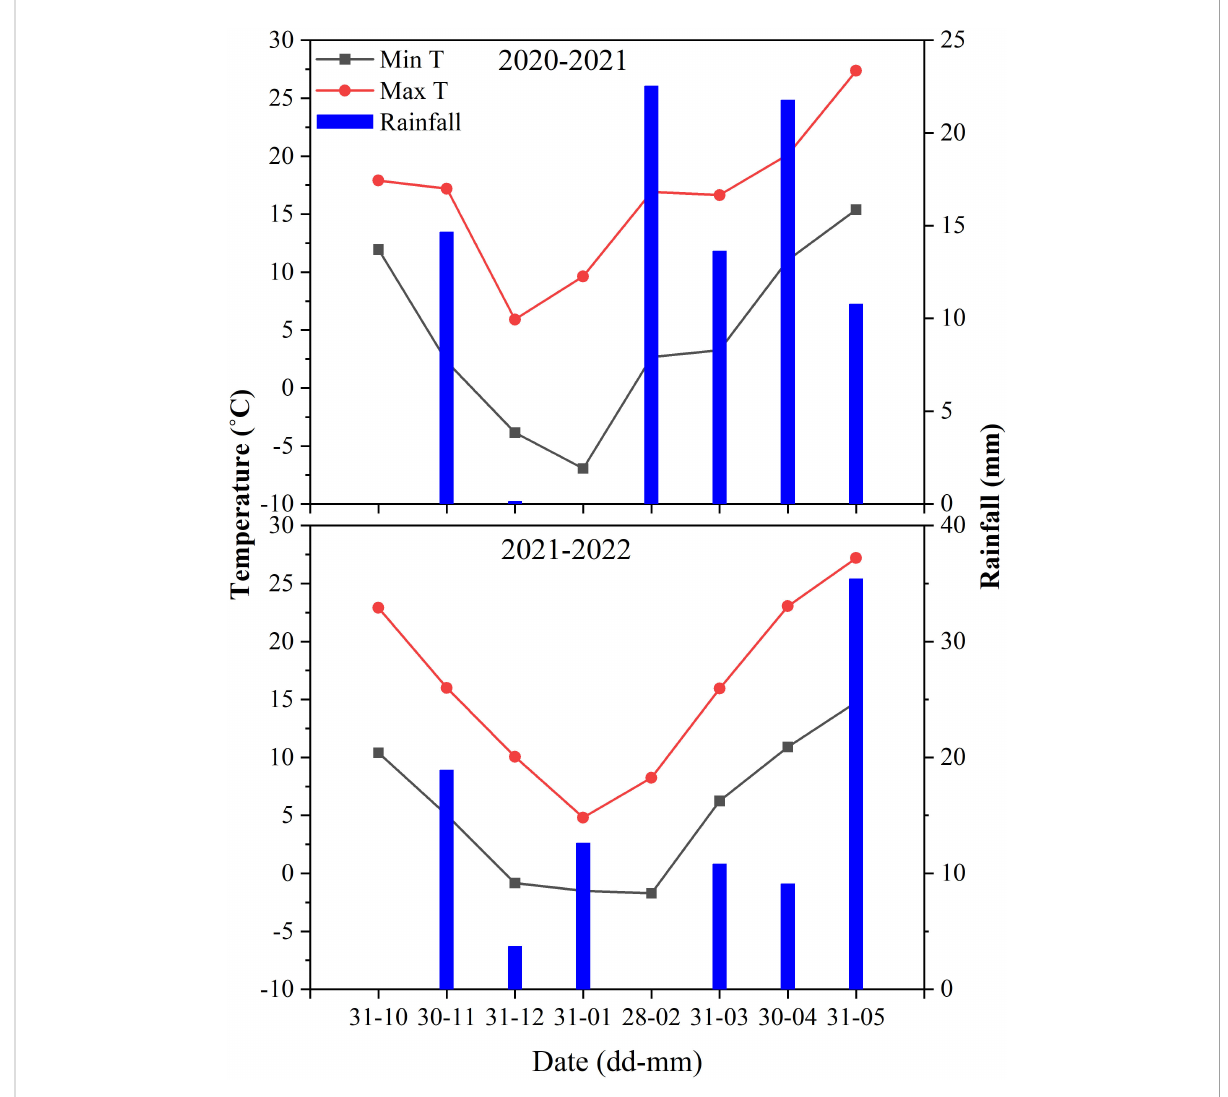
FIGURE 1 Monthly rainfall and maximum, and minimum temperature during the winter wheat growing season in 2020-2021 and